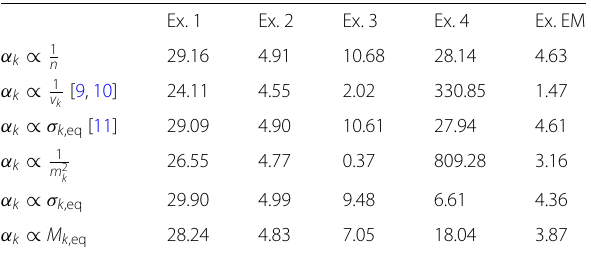
Table 2 Variances for multi-sample estimator for the four examples in Appendix C and the environment map example ( × 10 − 3 ) for balance heuristic using equal count of samples, for the count inversely proportional to the variances of independent estimators [9] and [10], for the provably better, non-balance heuristic, estimator defined in [11], and for the three new estimators defined in this